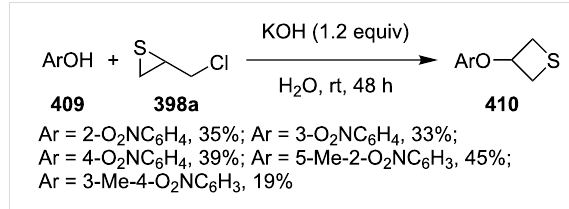
Scheme 88: Synthesis of 3-(nitrophenyloxy)thietanes 410 from nitro- phenols 409 and chloromethylthiirane ( 398a ).